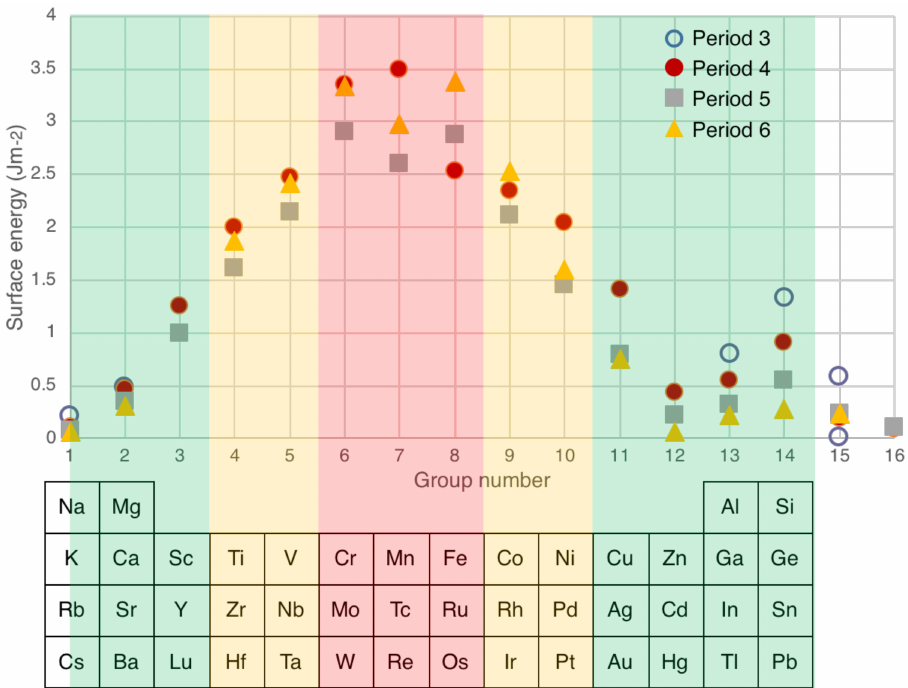
Figure 10. DFT calculations of surface energies of solid particles with a Wulff morphology [147]. The surface energies are banded into low, medium and high values (green, amber and red, respectively, following [89]), with the relevant portion of the periodic table shown